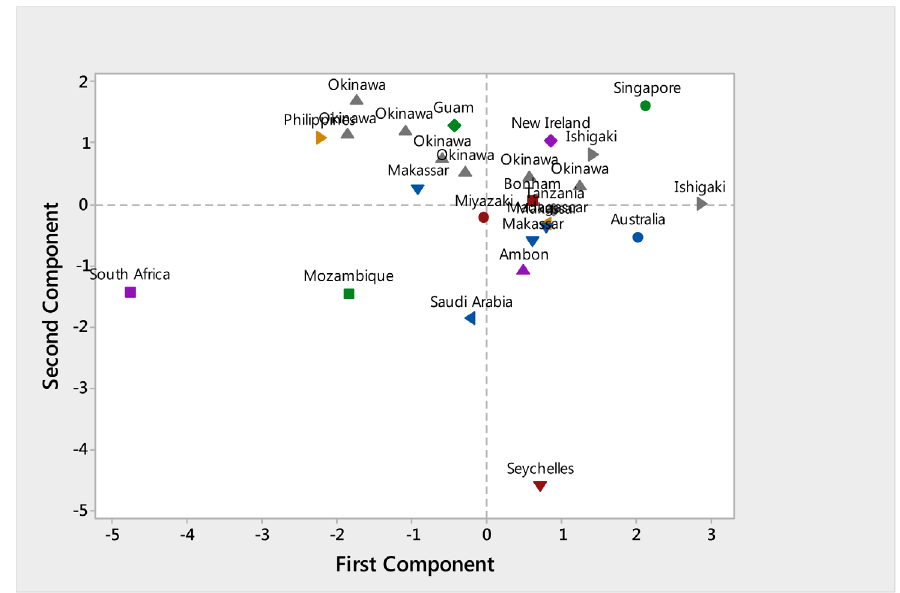
Figure 2. Distribution of morphological characters of Lethrinus harak populations with respect to the two principal components (axes) of the principle component